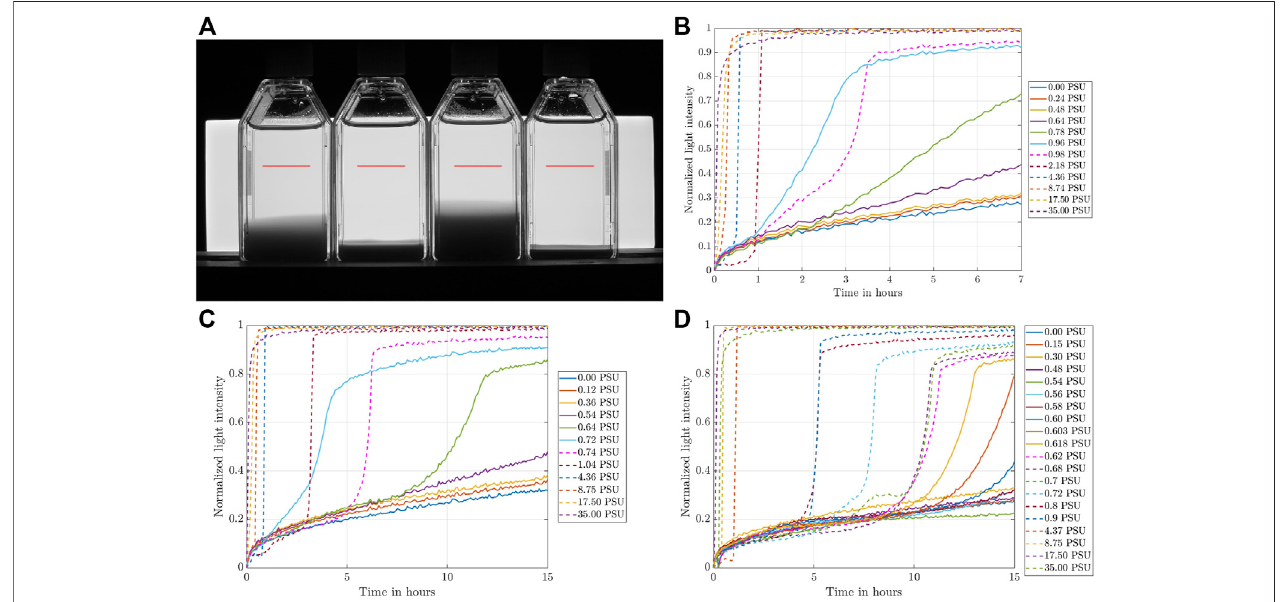
FIGURE 5 | (A) Characteristic picture taken by the camera and observation level to measure the light intensity over time (marked in red), and normalized light intensity over time for various salt concentrations recorded at the observation level for (B) 4 ppt, (C) 6 ppt, and (D) 8 ppt.